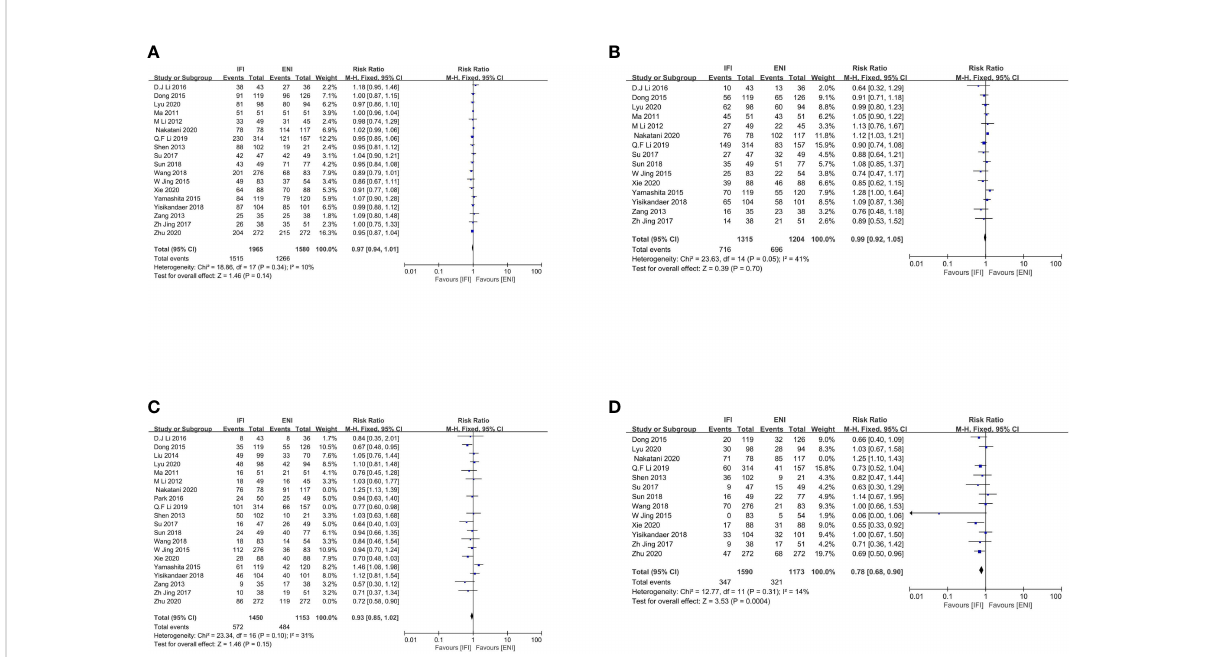
FIGURE 2 Forest plot of 1- (A) , 2- (B) , 3- (C) and 5-years (D) overall survival rate. IFI, involved fi eld irradiation; ENI, elective nodal irradiation; M-H, Mantel- Haenszel; CI, con fi dence